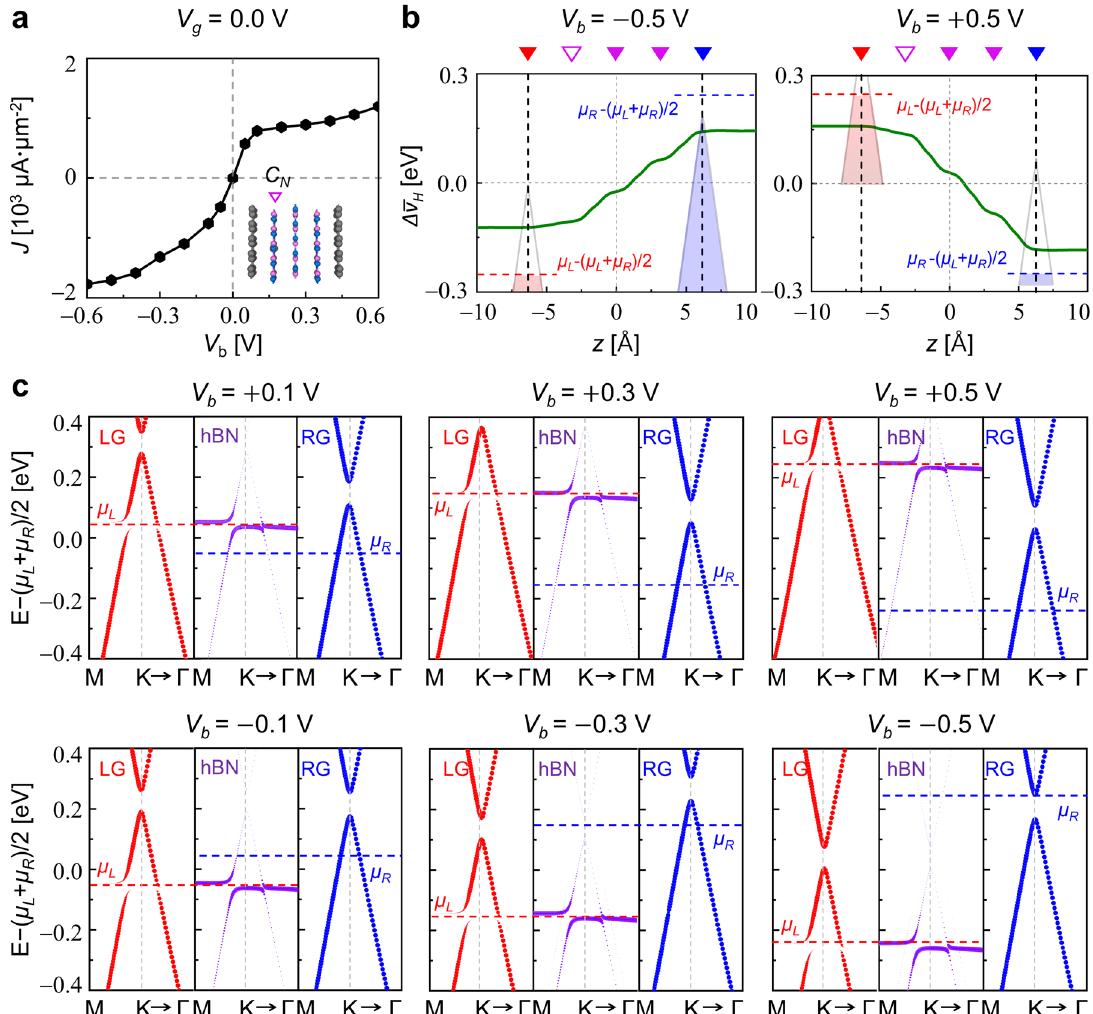
Fig. 4 Critical effects of the defect location. a The zero- V g J − V b characteristic of LG/3L hBN/RG junction with a C N defect placed at the left- most hBN layer (inset). b The Δ v H distributions at V b = − 0.5 V (left) and + 0.5 V (right). Red, purple fi lled, purple empty, and blue down triangles indicate the positions of LG, pristine hBN, defective hBN, and RG layers, respectively. c The junction band structures projected onto LG (left panels), hBN (central panels), and RG (right panels) are shown for V b = + 0.1 V, + 0.3 V, + 0.5 V (upper panels) and V b = − 0.1 V, − 0.3 V, − 0.5 V (lower panels). The sizes of circles quantify the strength of orbital